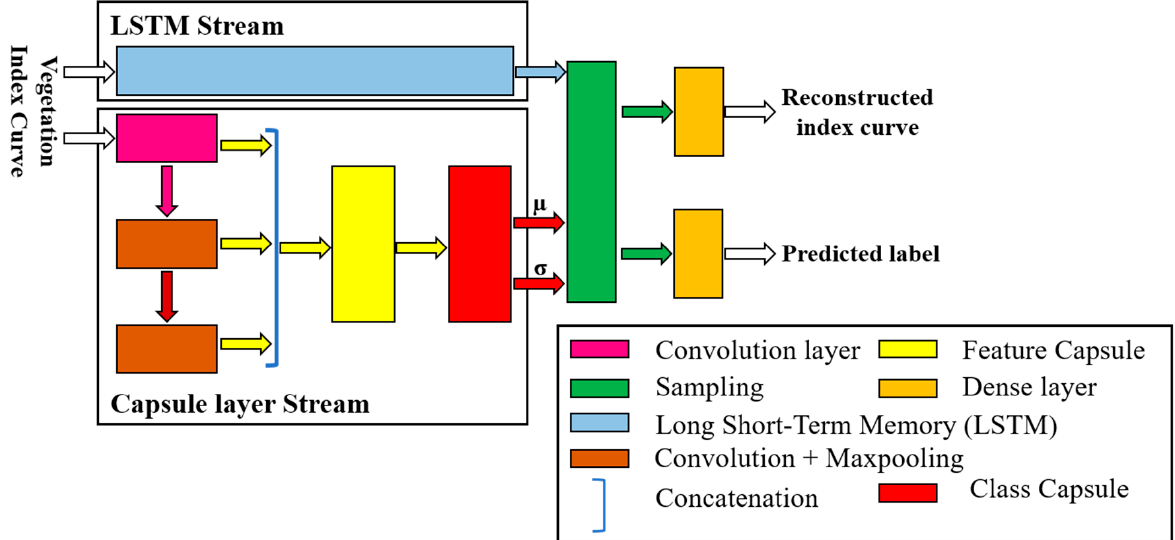
Figure 3. Proposed variational capsule network (VCapsNet) architecture with pooling (µ and σ denote mean and standard deviation respectively).